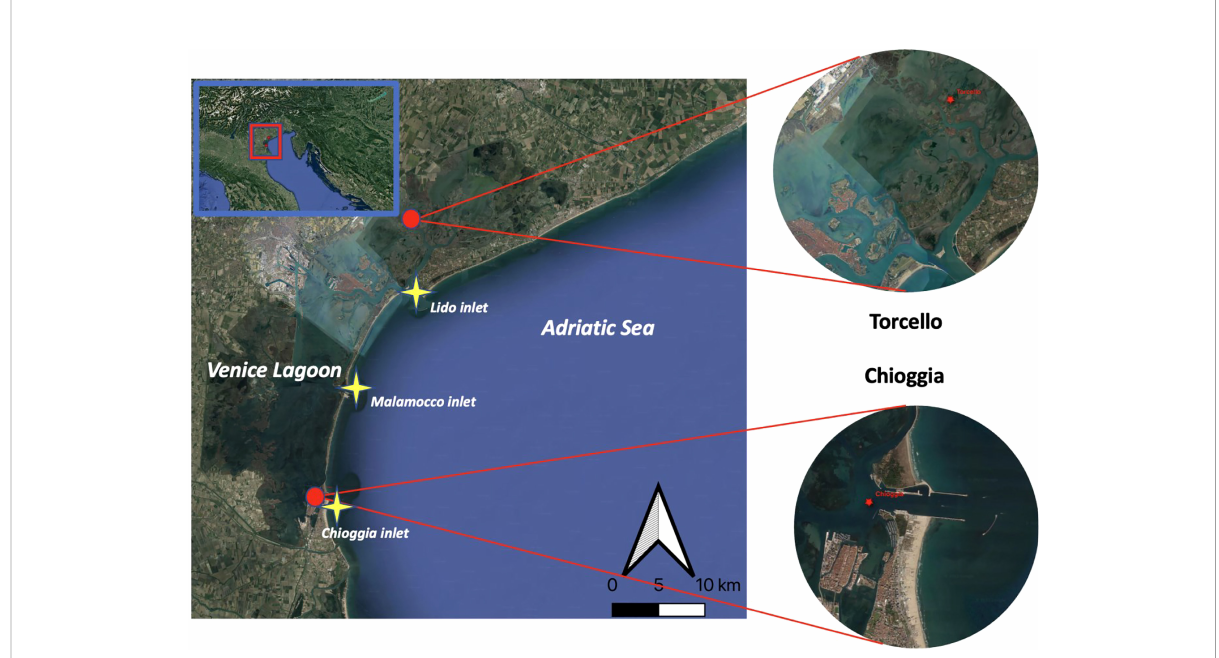
FIGURE 1 Sampling sites for eDNA collection. Represented is the Venice Lagoon, with red dots indicating sampling stations of Torcello (station 5) and Chioggia (station 15). The three lagoon inlets are indicated by yellow stars. Map created using the Free and Open Source QGIS from Google Earth satellite